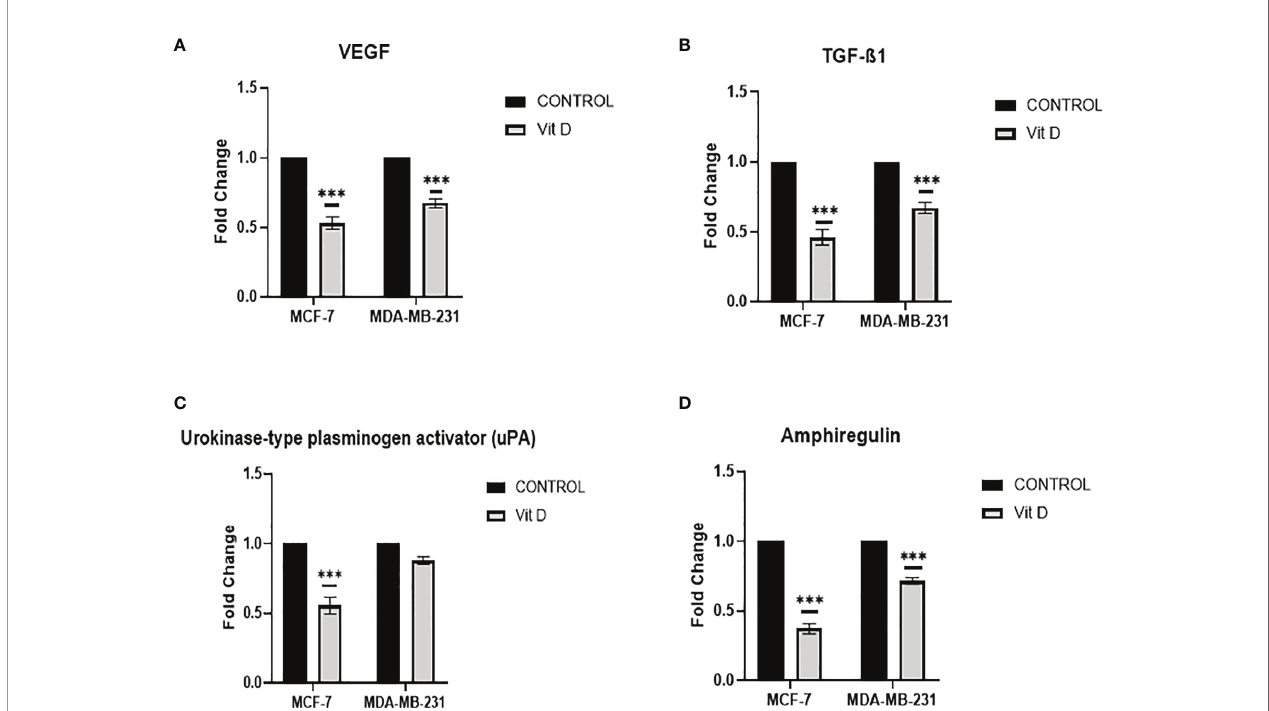
FIGURE 4 | VM Proteome Pro fi ler array analysis in MCF-7 and MDA-MB-231 cells after calcitriol treatment. VEGF (A) and TGF- b 1 (B) , urokinase-type plasminogen activator (uPA) (C) , and amphiregulin (D) protein levels in MCF-7 and MDA-MB-231 cells following calcitriol treatment. (***p < 0.001) represents statistically signi fi cant change in protein levels between treated and control (Ctrl) untreated cells at given time points.